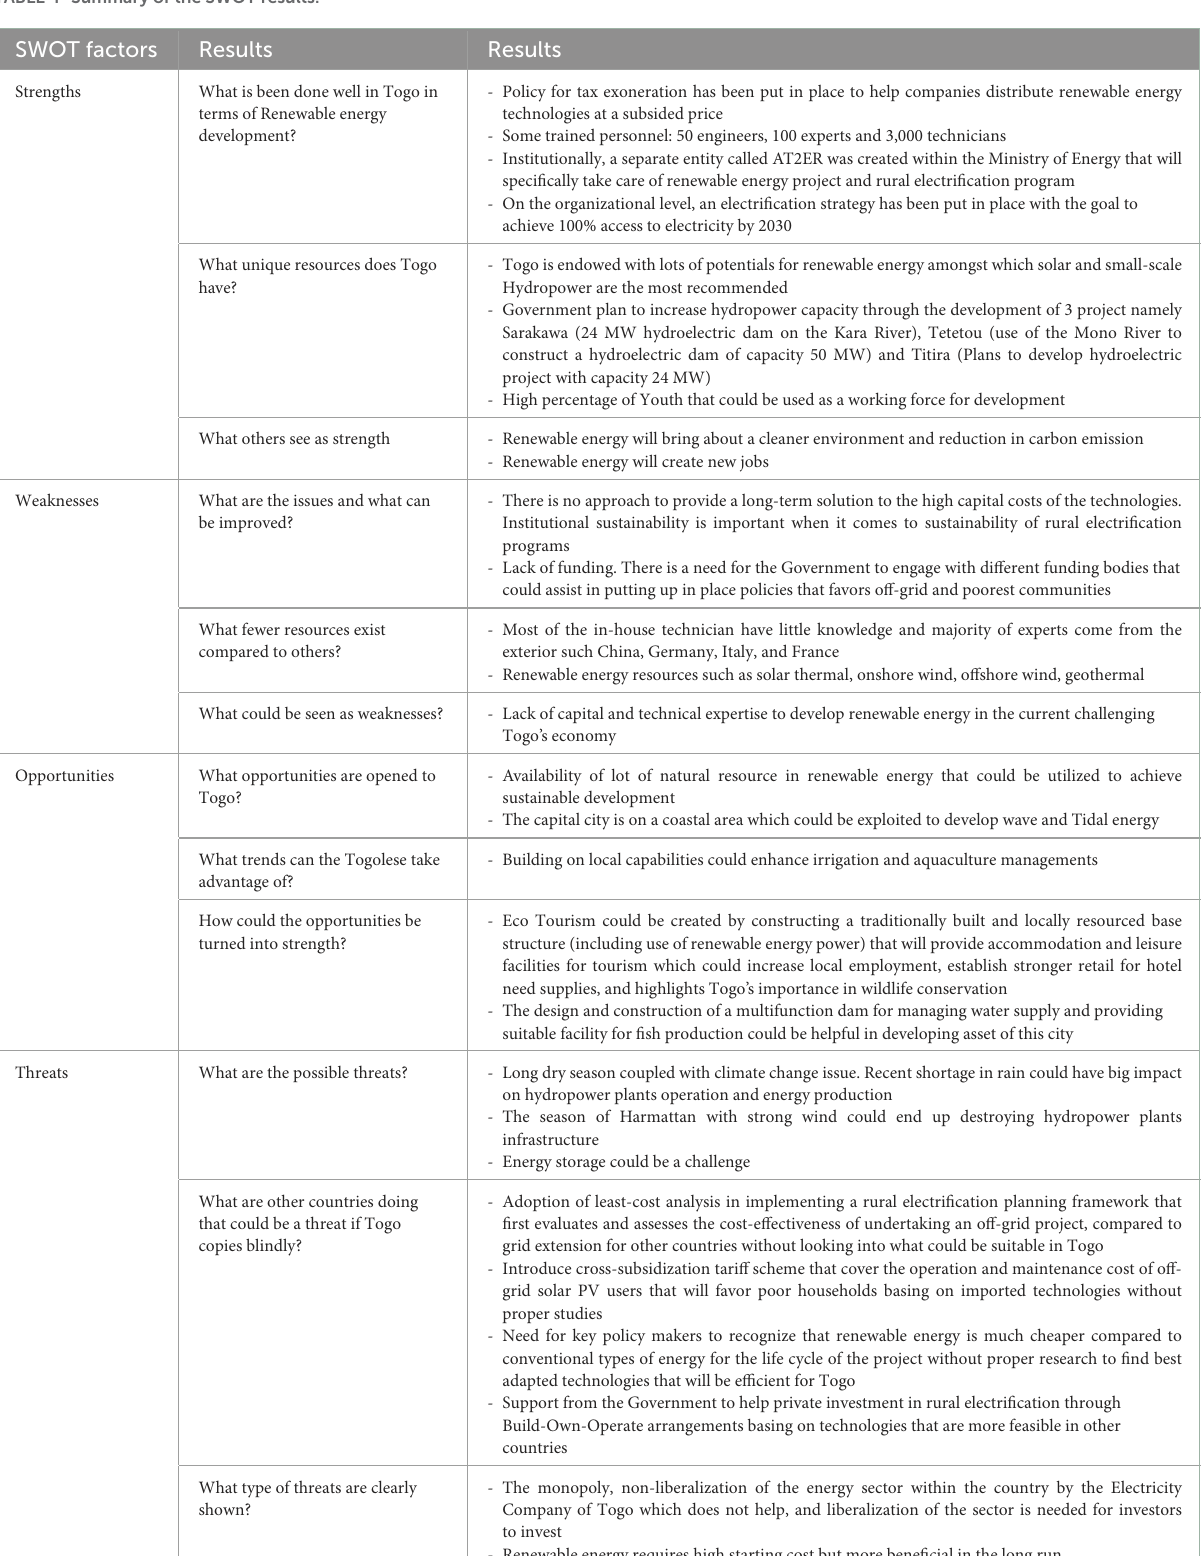
TABLE 4 Summary of the SWOT results. SWOT